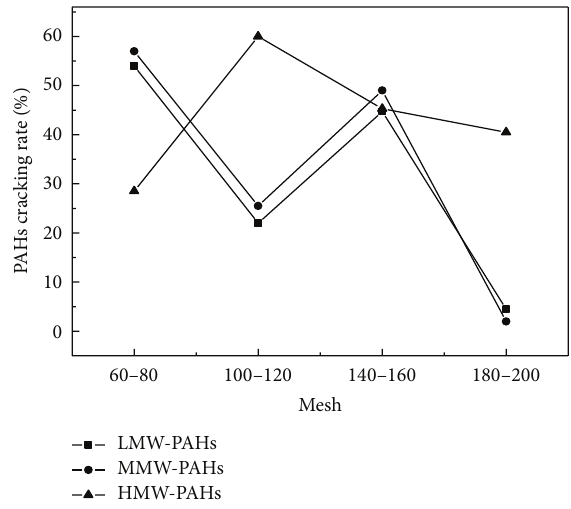
Figure 6: Relationship between the rings cracking rate distribution of PAHs and particle size of CaO.